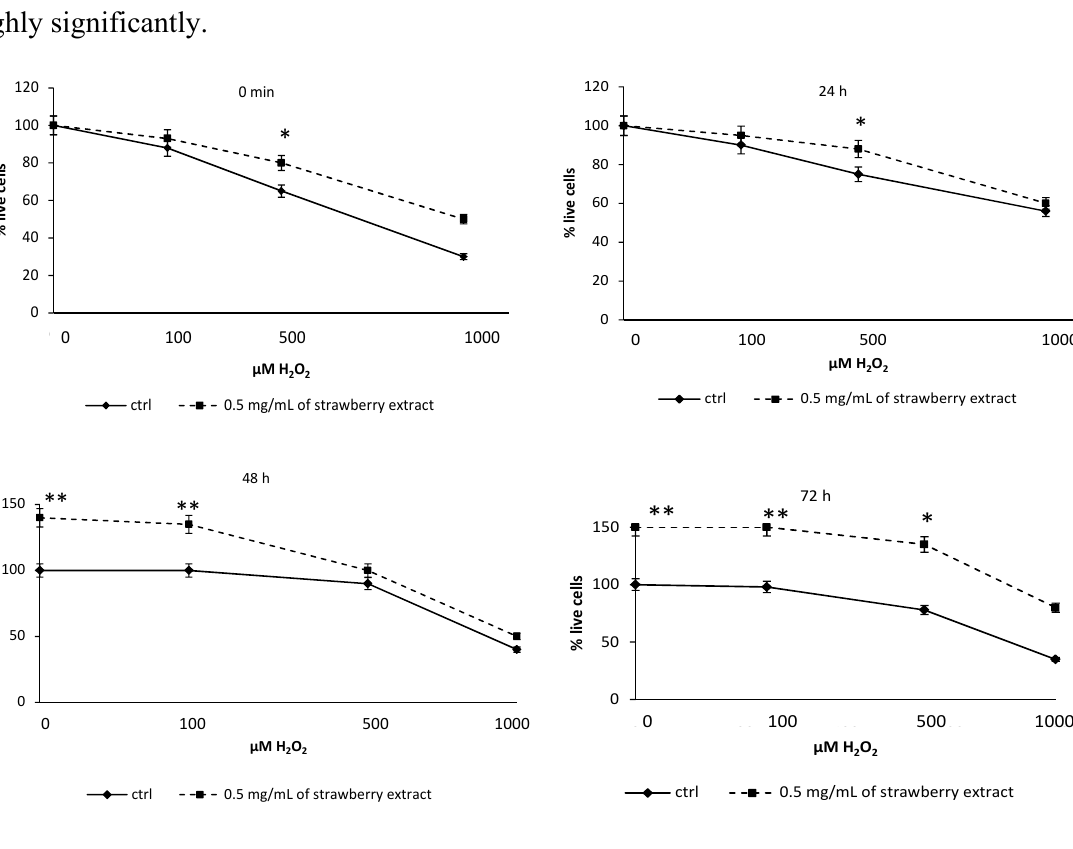
O . Control and pre-incubated cells were 2 2 O (0.1, 0.5 and 1 mM) and analysed in 2 2